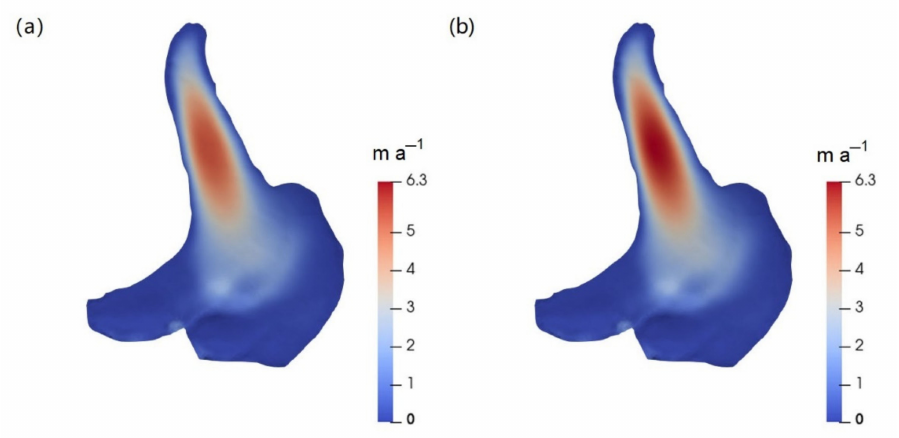
Figure 13. Modeled surface velocities in the year 2016 with geothermal heat flux of 50 ( a ) and 60 ( b ) mW m − 2